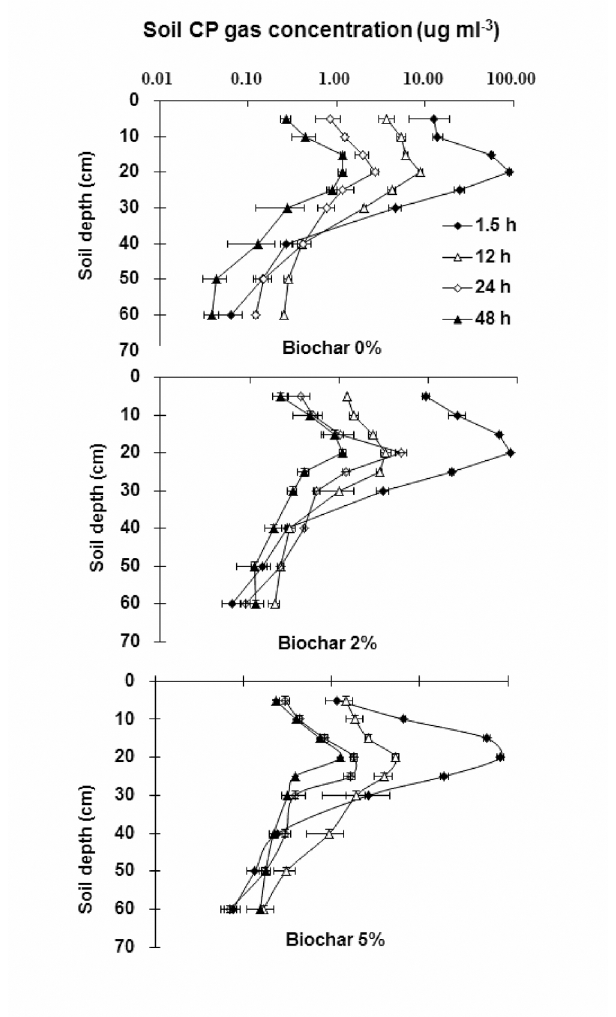
Fig 4. Concentration of CP in the soil-gas phase in soil column